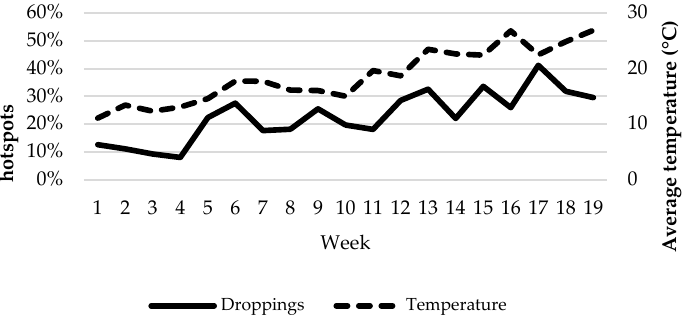
Figure 9. Weekly percentage of droppings in the two main hotspots for dung deposition according to ambient temperature.